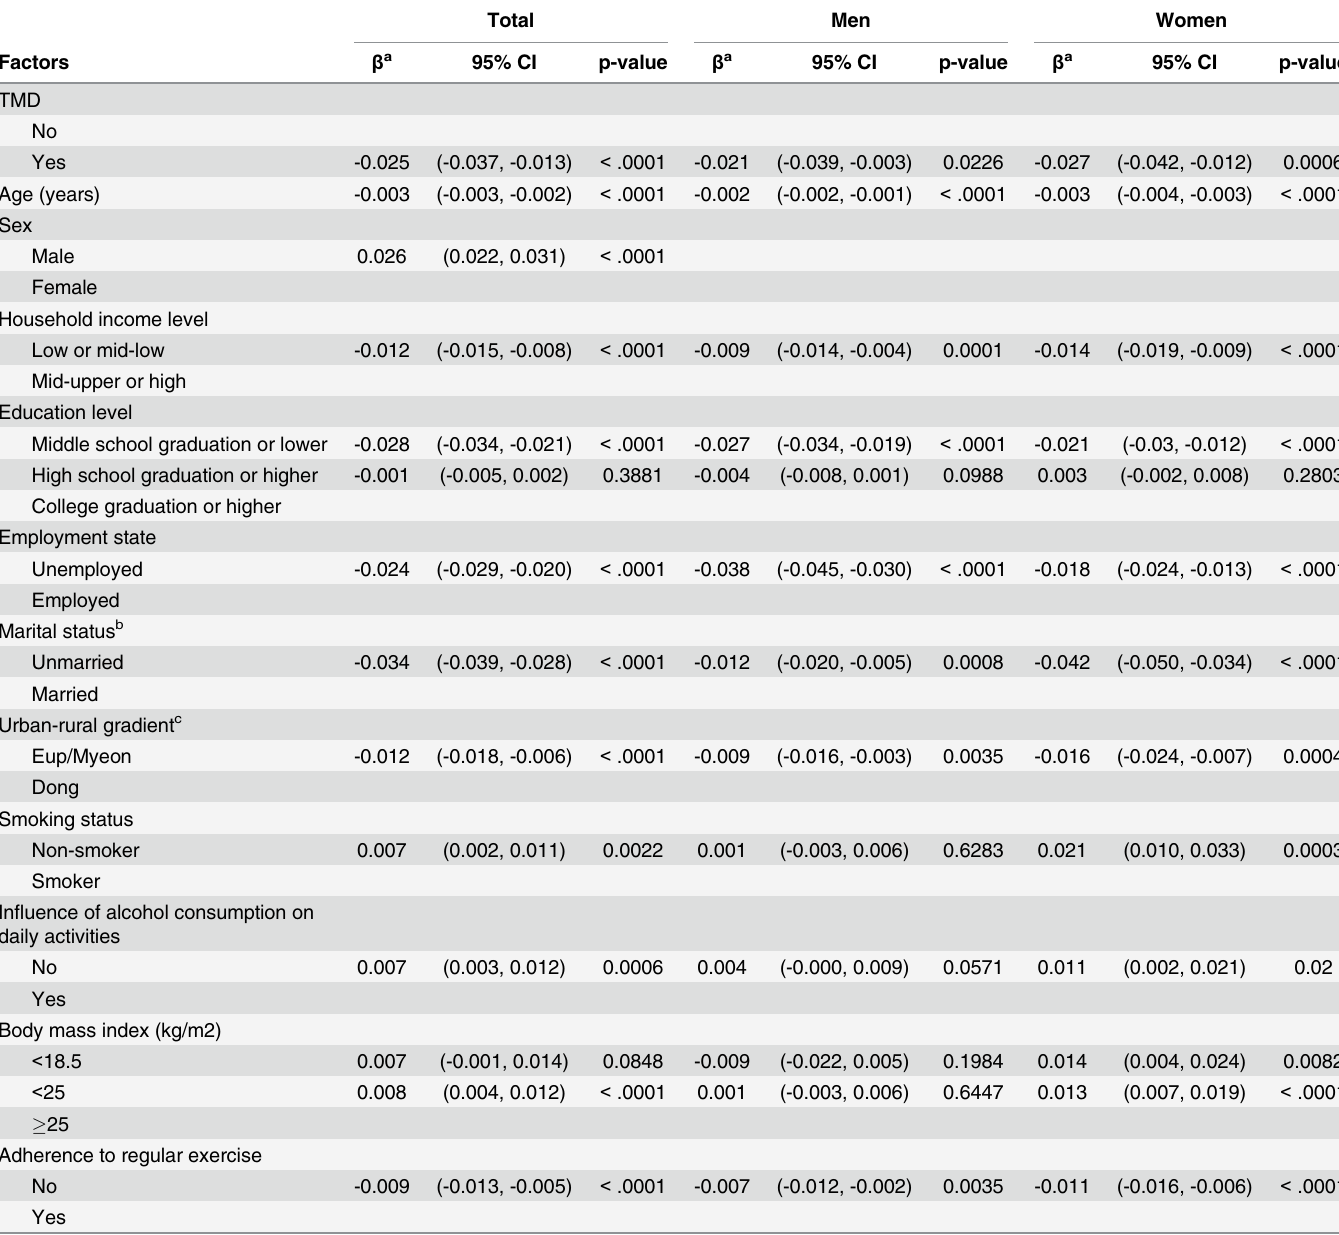
Table 2. Association between chronic TMD and quality of life as assessed by EQ-5D in participants aged (cid:1) 19 years of KNHANES Ⅳ , 2007 to